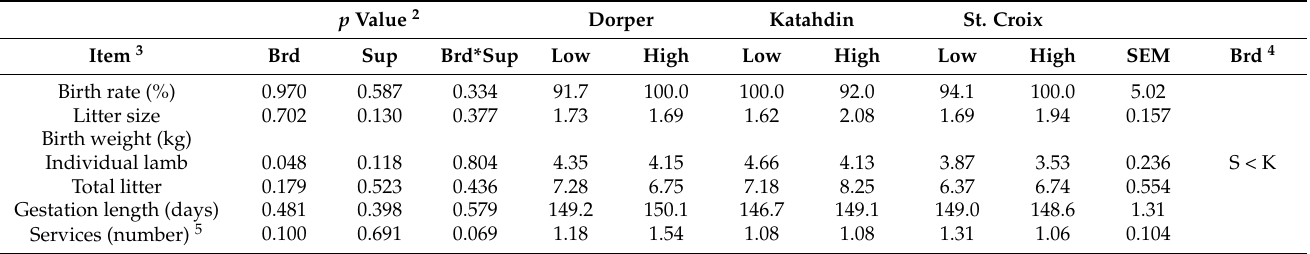
Table 4. Effects of breed and supplementation treatment on reproductive performance of hair sheep 1 .